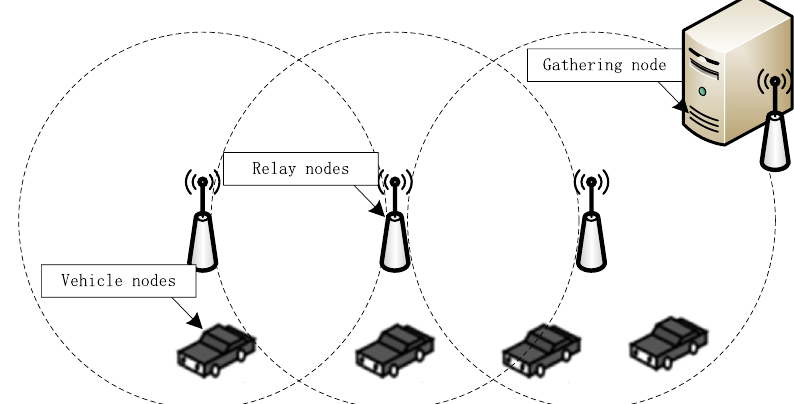
Figure 1: Structure of the three - layer vehicle